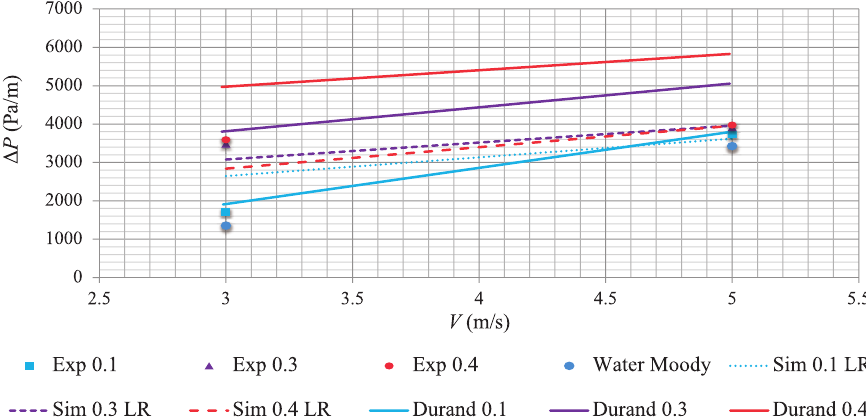
Fig. 1 Pressure drop comparison between experimental, Durand & Condolios correlation and simulated results, using the Mixture Model with a Low Reynolds k-ε Turbulence model, for settling particles with diameter of 0.44 mm, density of 2470 kg.m –3 and volumetric fractions from